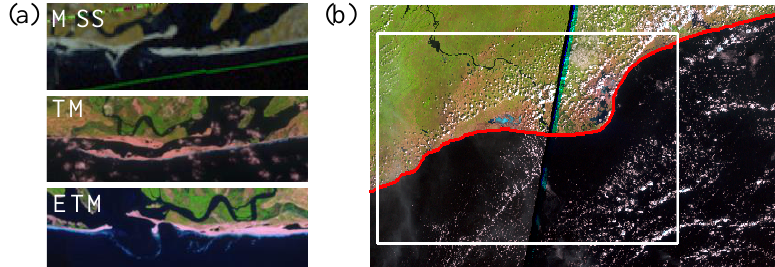
Figure 2. ( a ) Pseudo-color images using 432 bands and 543 bands for the multispectral scanner (MSS) and thematic mapper (TM)/enhanced thematic mapper (ETM+) images ( b ) extraction of the shoreline of the Volta River Delta. The red line is the example of extracted shoreline, and the white polygon is the intersected polygon.